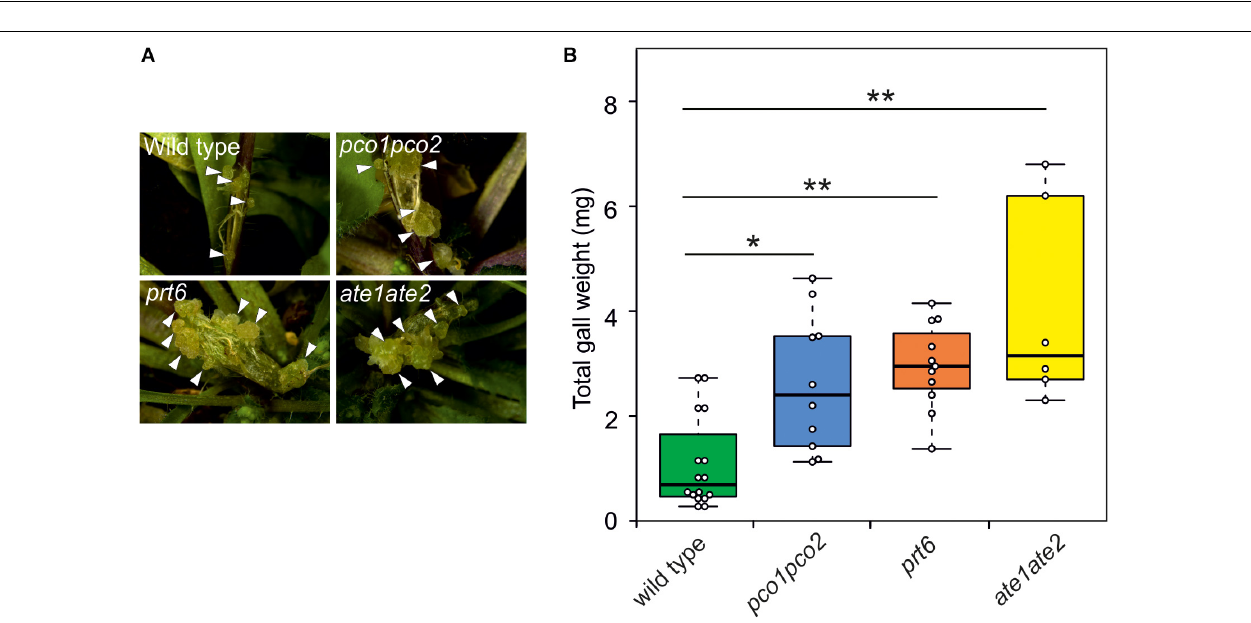
FIGURE 4 | Arabidopsis lines with a constitutively repressed hypoxia response show reduced crown gall symptoms. (A) Representative images of crown gall disease symptoms at 21 dpi in erf-vii and wild type plants. Scale bar, 1 mm. Crown galls are indicated with white arrows. (B) Gall fresh weight of erf-vii and wild type plants at 21 dpi. Data are presented as boxplots. Stars indicate a statistically significant difference [ ∗ < 0.05, ∗∗ < 0.01, ANOVA followed by Holm-Sidak post hoc test].